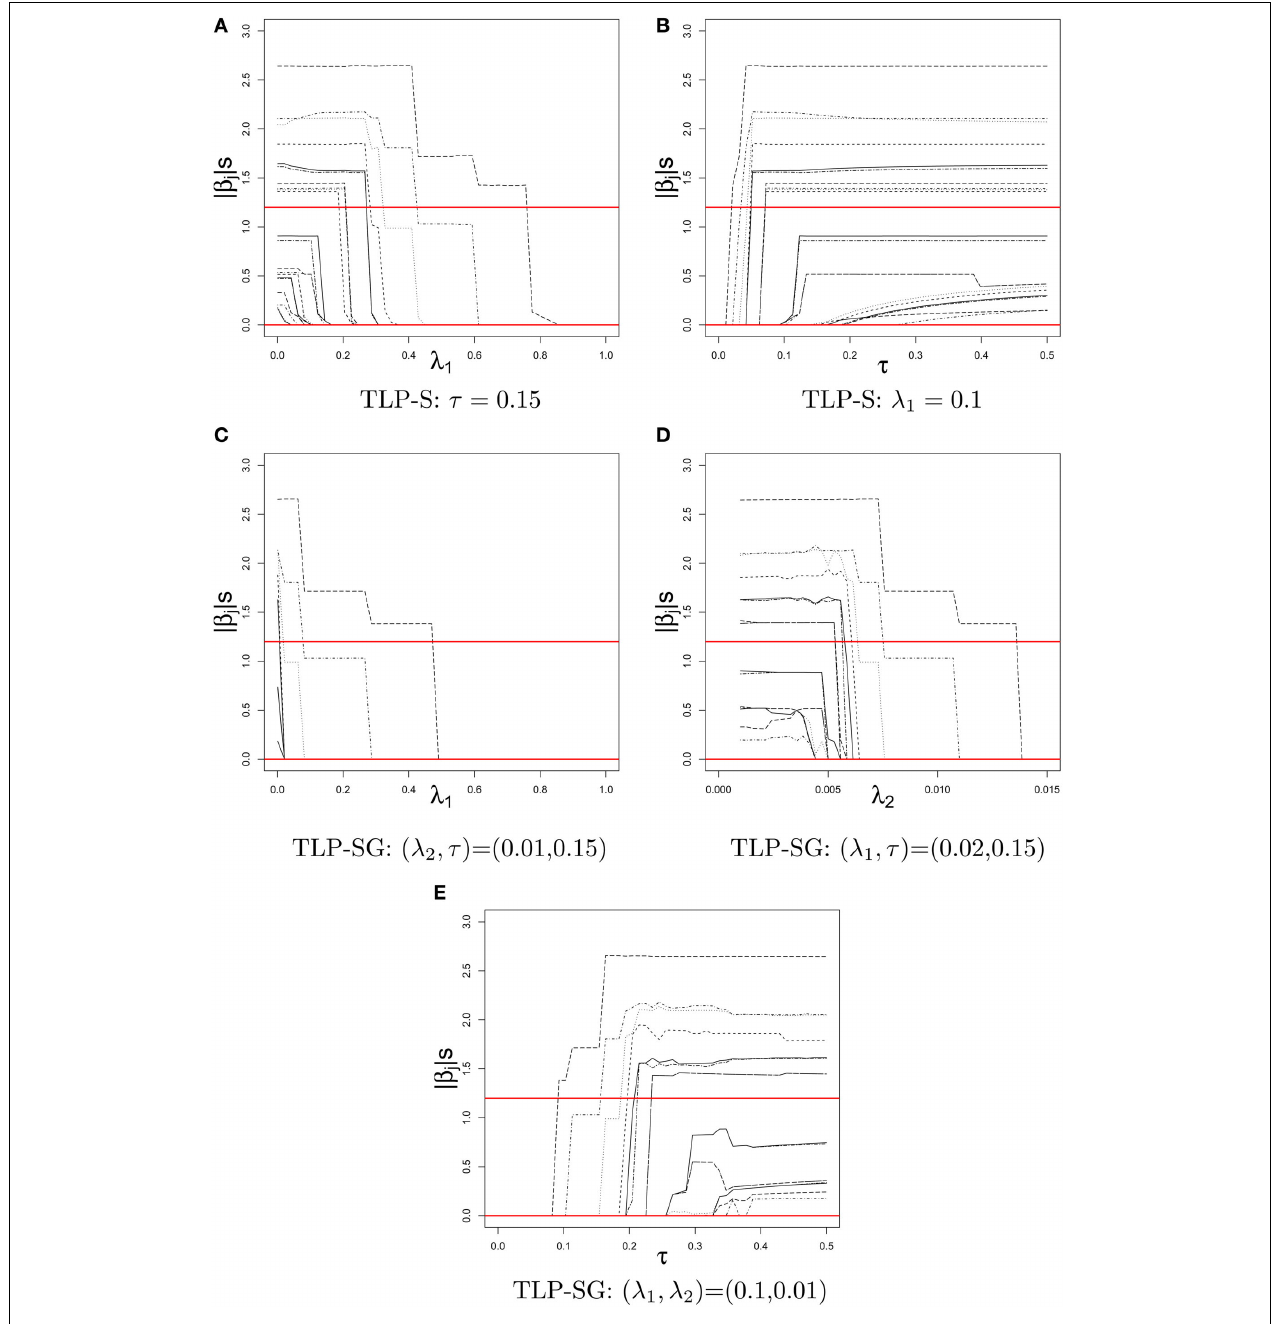
horizontal lines. (A) TLP-S: τ = 0 . 15. (B) TLP-S: λ 1 = 0 . 1. (C) TLP-SG: ( λ 2 ,τ ) = (0 . 01 , 0 . 15). (D) TLP-SG: ( λ 1 ,τ ) = (0 . 02 , 0 . 15). (E) TLP-SG: ( λ 1 ,λ 2 ) = (0 . 1 , 0 .